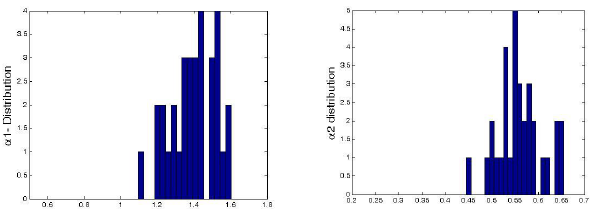
Figure 7. Distribution of  1 (left panel) and  2 (right panel). Fig. 7. Distribution of α 1 -values (left panel) and α 2 -values (right panel).